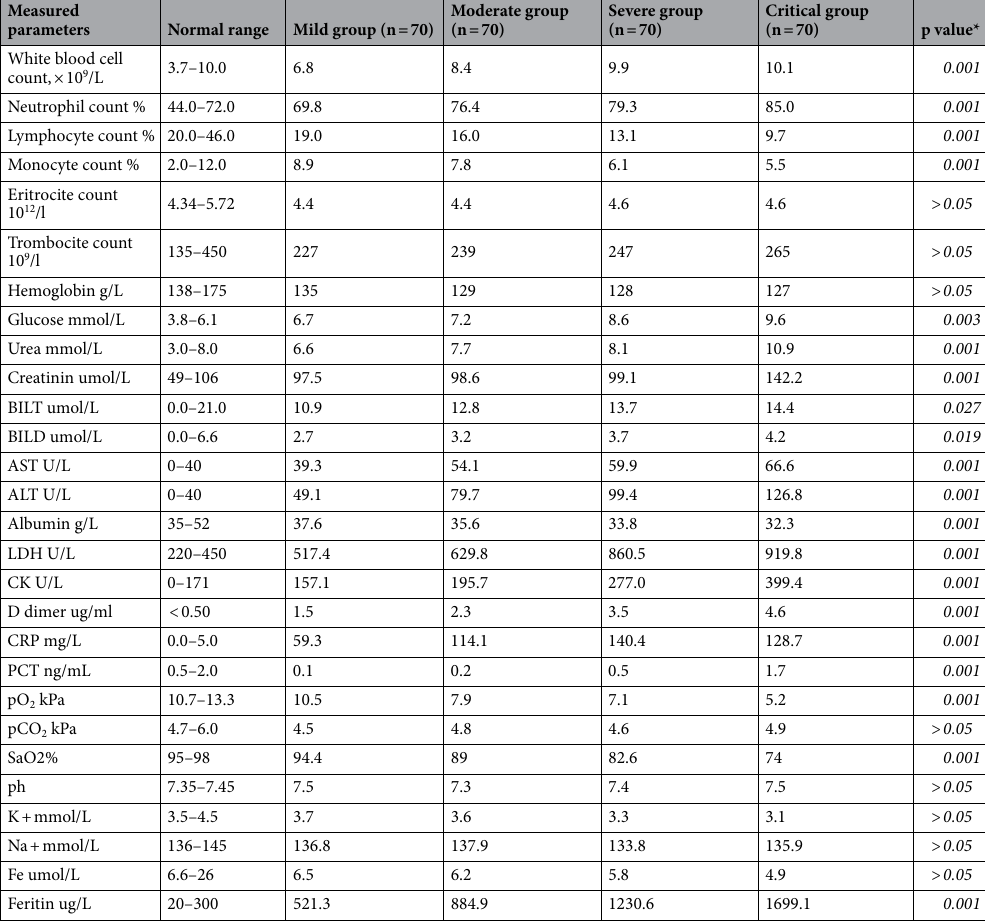
Table 2. Laboratory findings of patients with COVID-19. Significant values are in italics. Data expressed as median. *p values indicate differences between mild, moderate and severe group p < 0.05 was considered statistically